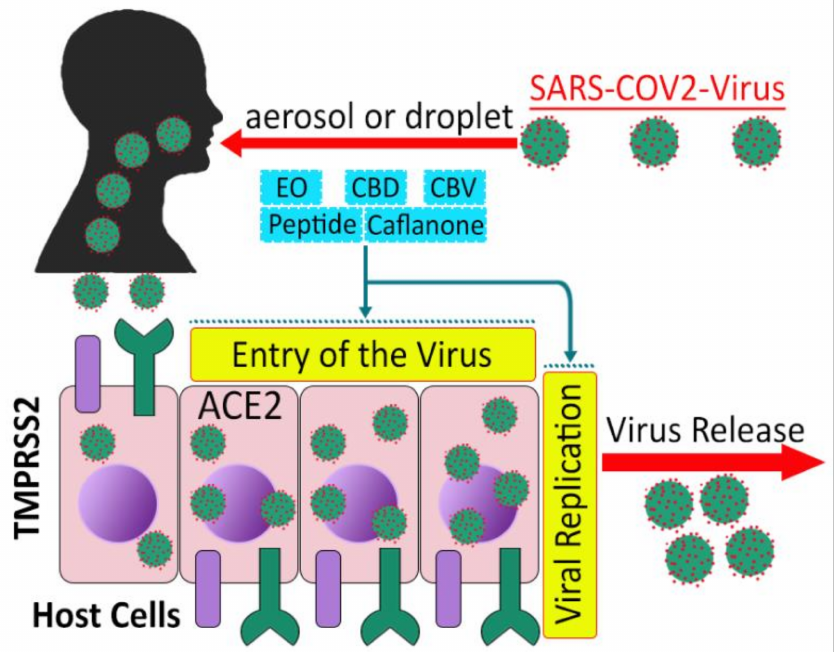
Figure 4. Potential effects of cannabis compounds on SARS-CoV-2 entry and replications (adapted from